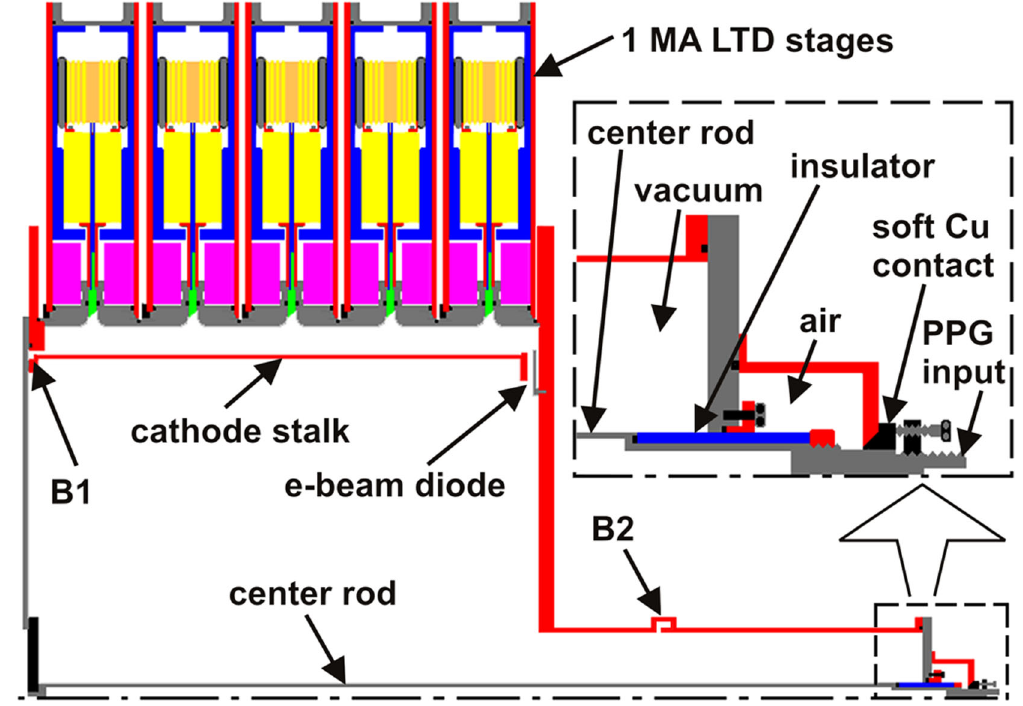
FIG. 11. (Color) Design of the five-stage LTD module with e-beam diode load. The cores of the stages were premagnetized before each shot without opening the module to the atmosphere; the PPG pulse was applied to the right end of the center rod that was disconnected from the grounded body of the module by removing the soft Cu